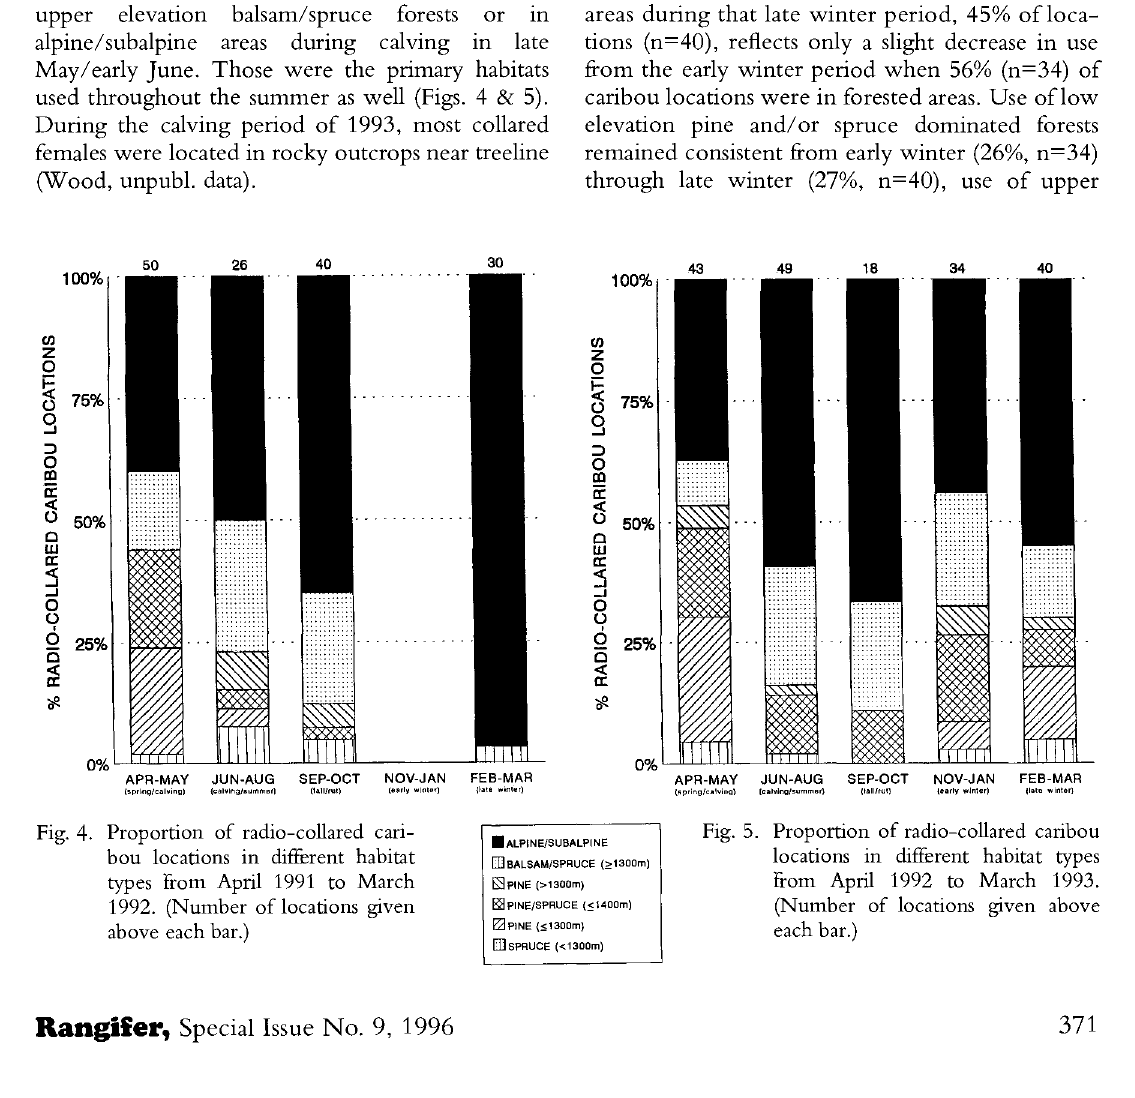
Fig. 5. Proportion of radio-collared caribou locations in different habitat types from Apnl 1992 to March 1993. (Number of locations given above each